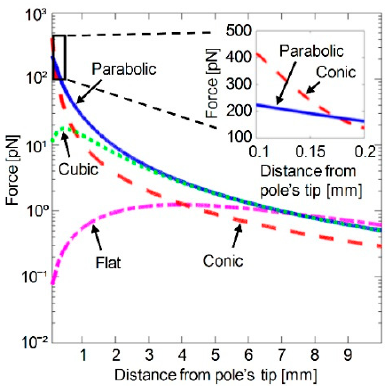
Figure 5. The magnetic force as a function of the distance from the pole’s tip for various magnetic pole tips. Inset: The magnetic force as a function of the distance from the pole’s tip for a conic pole tip and a parabolic pole tip.